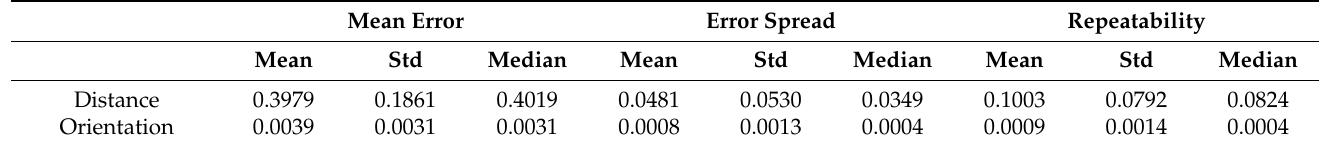
Table 4. Mean, standard deviation, and median for experimental inner areas.